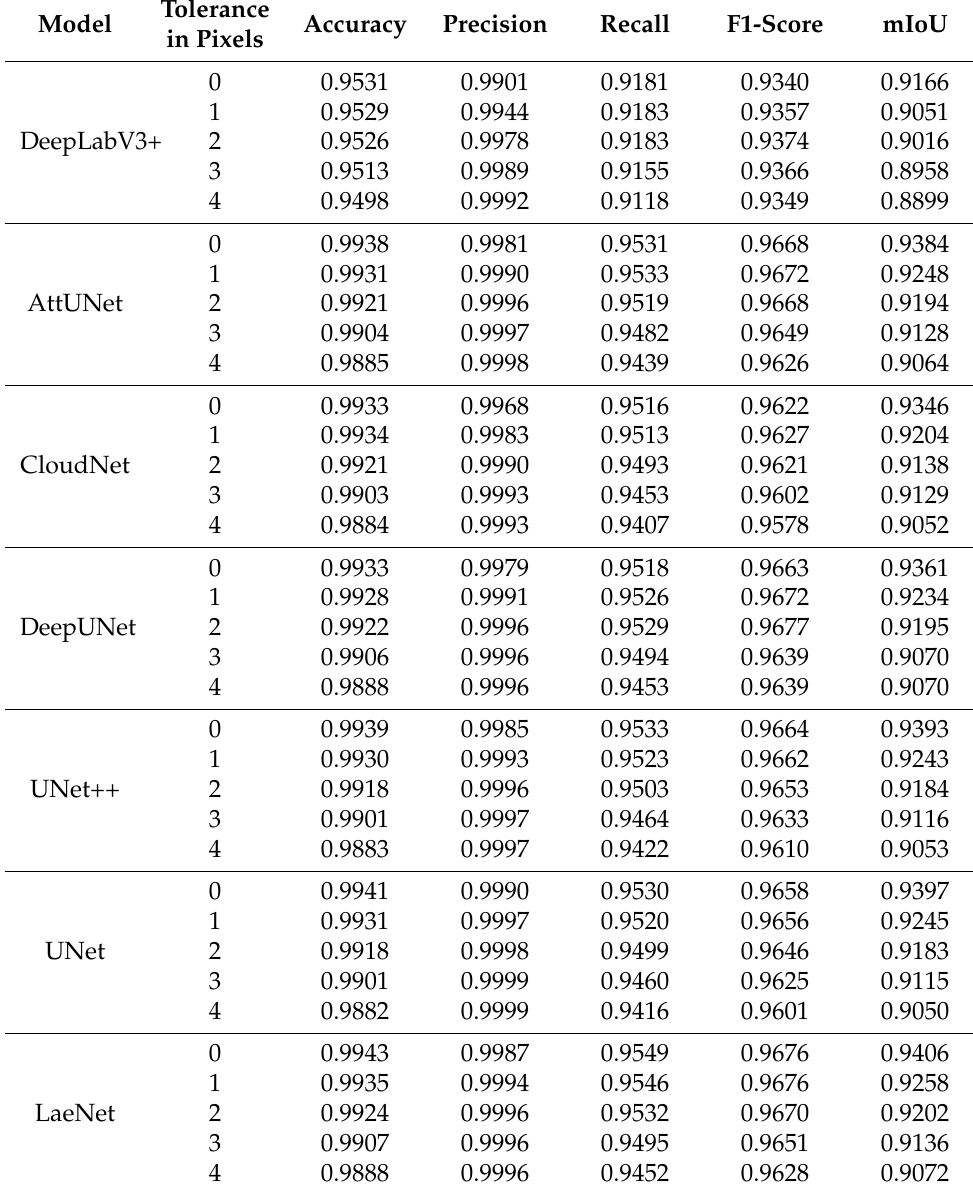
Table 5. Performance evaluation with the 0-, 1-, 2-, 3-, and 4-pixel